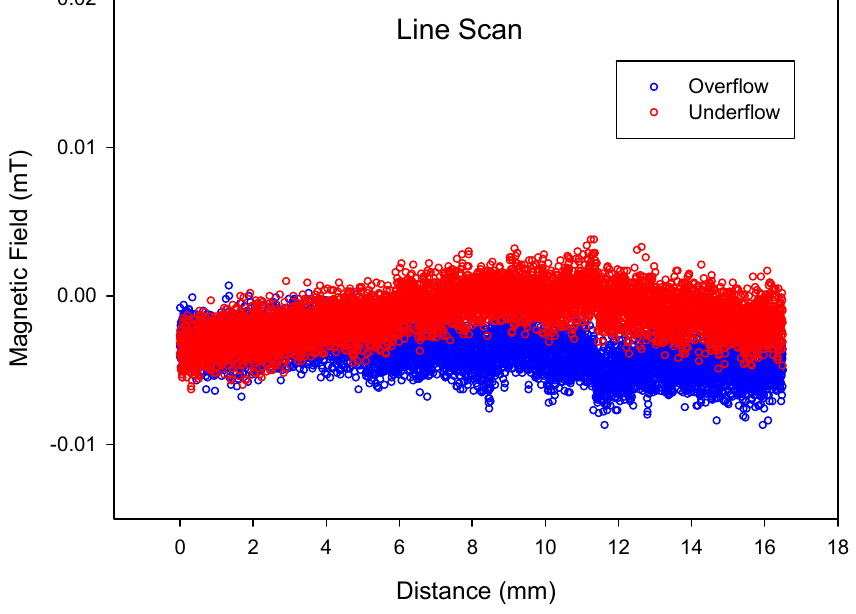
Figure 9. Line Scan of underflow and overflow after first hydrocyclone pass.